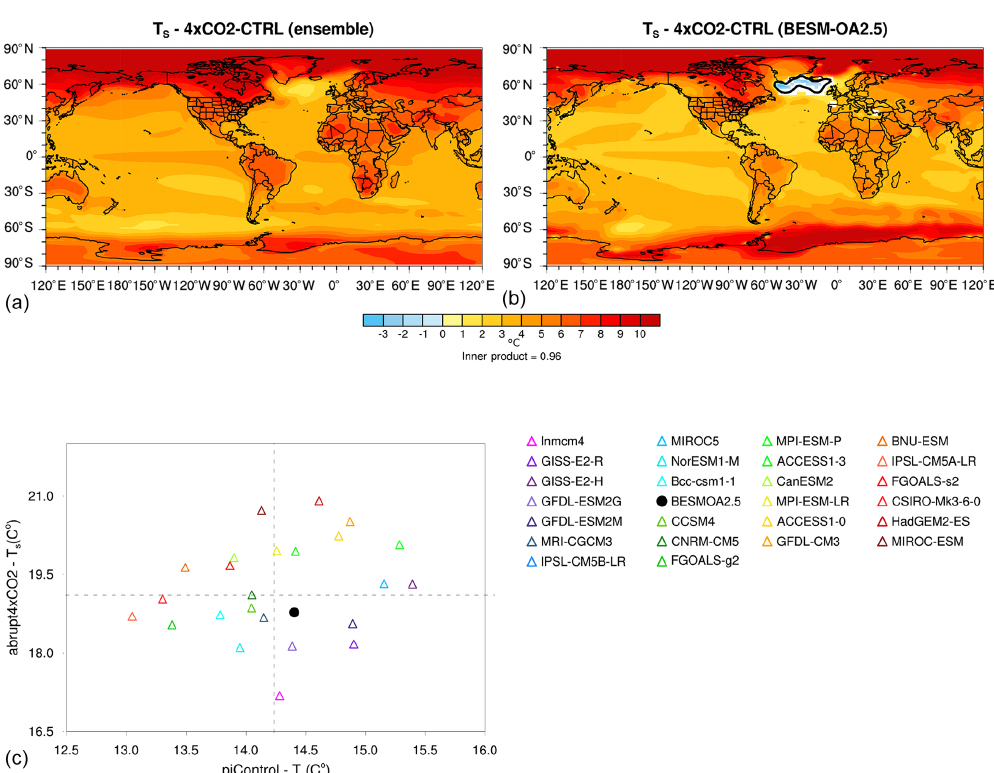
Figure 8. Differences (averaged over years 120–150) in surface temperature between the abrupt4xCO2 and piControl simulations in (a) the CMIP5 ensemble and (b) BESM-OA2.5. (c) A scatter plot of the global average surface temperature for the CMIP5 models used in the ensemble and BESM-OA2.5 (black dot). The shaded areas in (a) and (b) have confidence levels greater than 90%; the black line represents the contour line of zero temperature